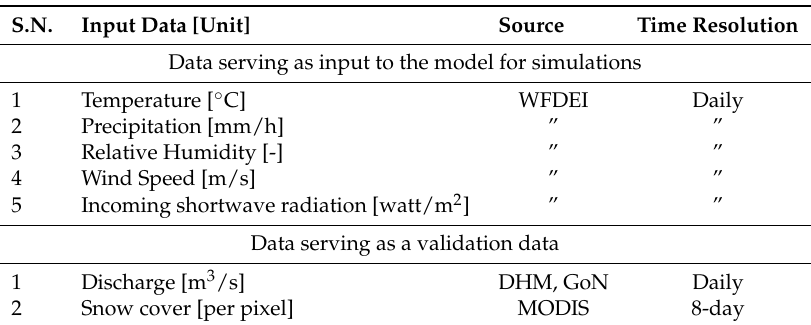
Table 1. Summary of hydrological model input